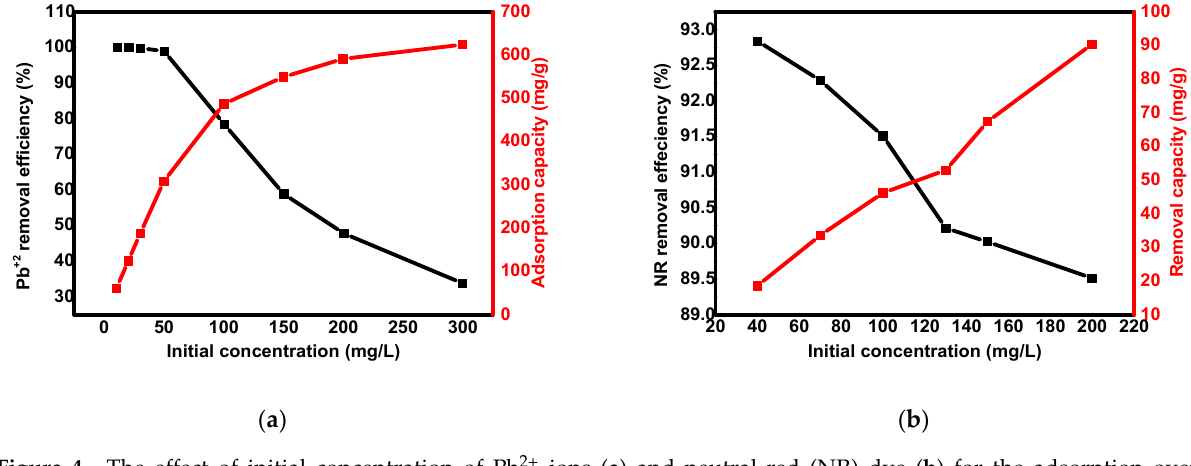
Figure 4. The effect of initial concentration of Pb 2+ ions ( a ) and neutral red (NR) dye ( b ) for the adsorption over MnFe 2 O 4 /GO nanocomposite.